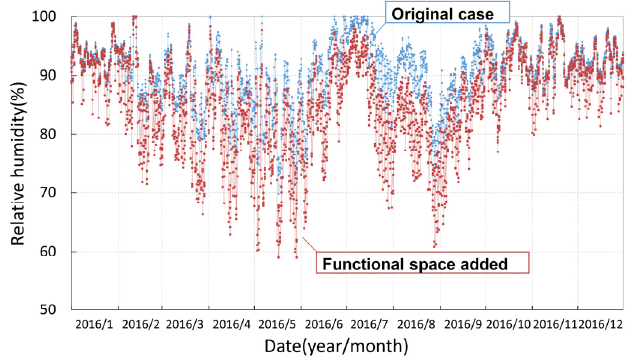
Figure 18. Comparison of air temperatures in the tomb chamber. Table 3. Statistics of the air temperature in the tomb chamber.